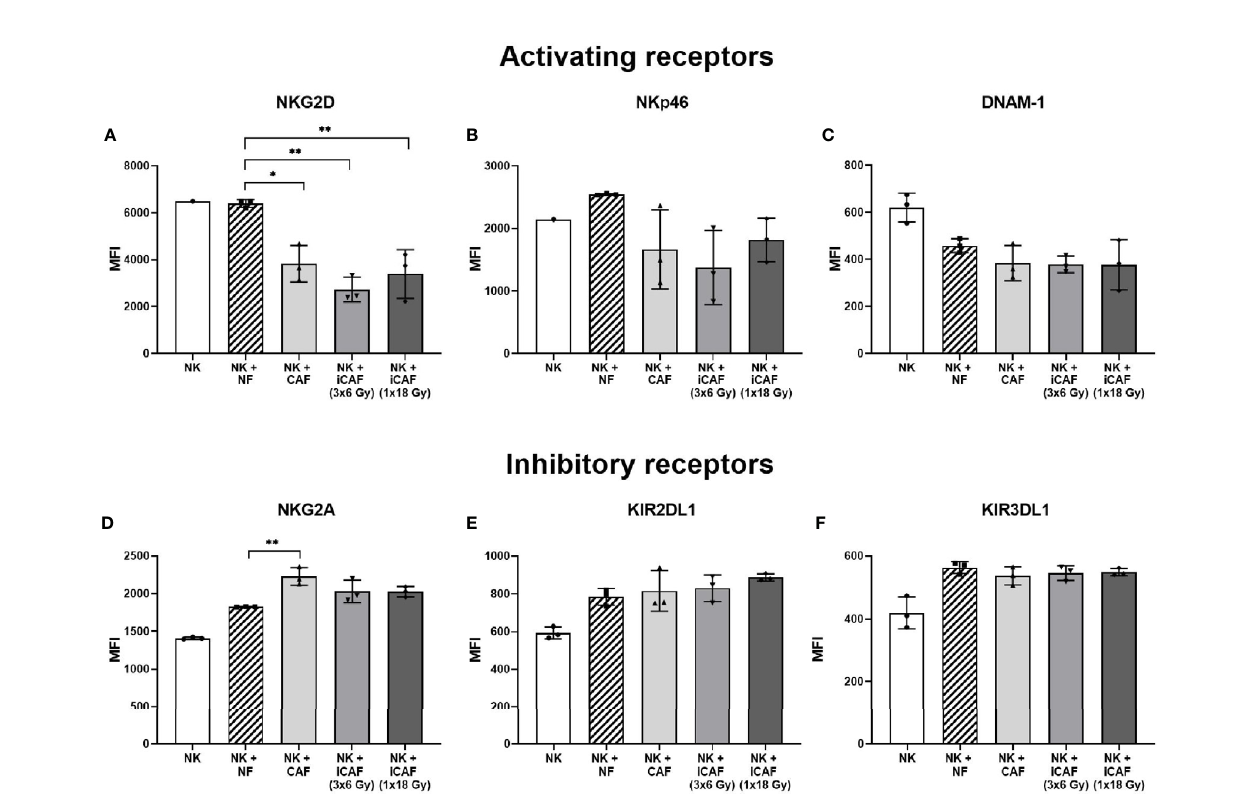
FIGURE 7 | Effects of cancer-associated fi broblasts (CAFs) on natural killer (NK) cell surface receptor expression. Following co-culturing with fi broblasts, isolated NK cells were analyzed by fl ow cytometry for their expression of NK cell surface markers (A) NKG2D, (B) NKp46, (C) DNAM-1, (D) NKG2A, (E) KIR2DL1 and (F) KIR3DL1. Results are presented as median fl uorescence intensity (MFI) and data represents mean (± SD) values from experiments with three different CAF donors. Statistical P -values between NK/NFs and NK/CAF-groups were determined using one-way ANOVA with Tukey correction for multiple comparisons * and ** indicates P < 0.05 and P < 0.01, respectively.